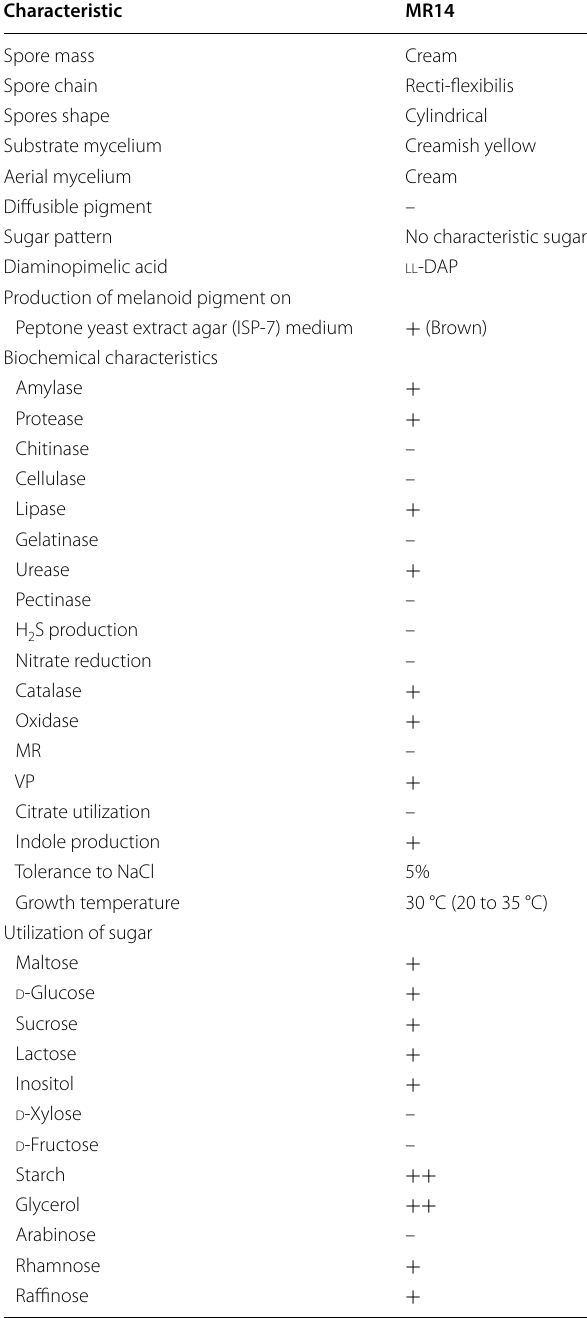
Table 2 Morphological, physiological and biochemical characteristics of Streptomyces sp.